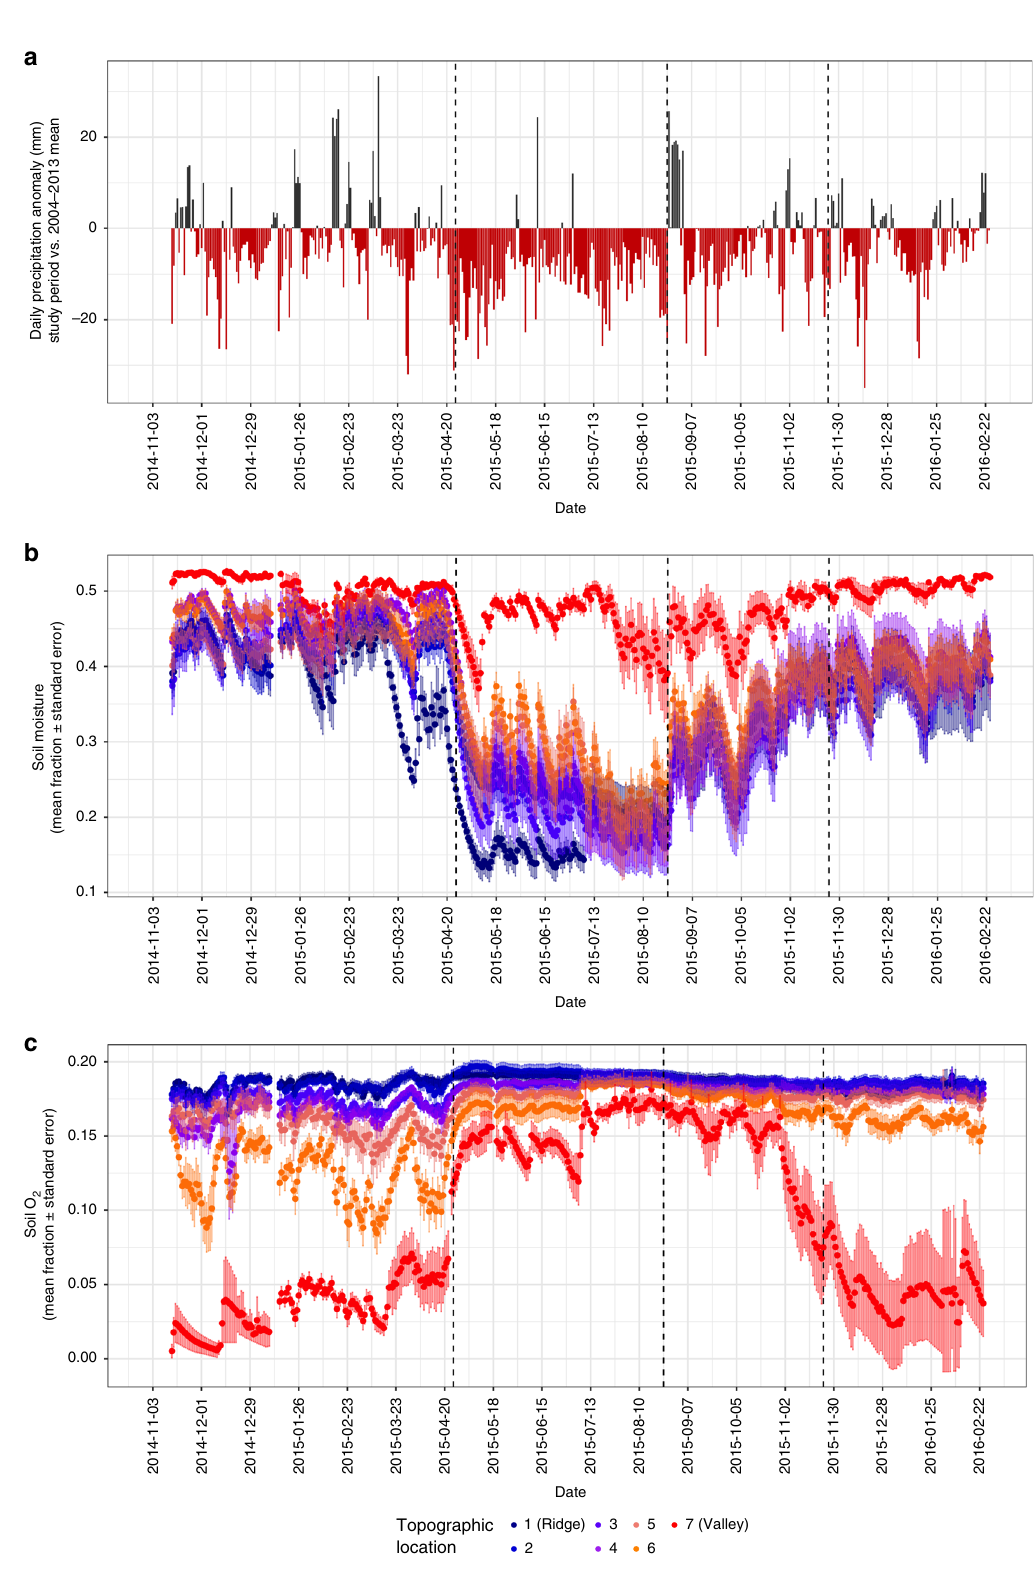
Fig. 2 Time series of rainfall and soil abiotic variables over the study period. Panels show a daily precipitation anomaly (2015 vs. 2004 – 2013), b soil moisture fraction, and c soil oxygen fraction from November 2014 to February 2016. Soil moisture and oxygen data points are the daily mean for each of the seven topographic locations (ridge to valley); error bars represent ±1